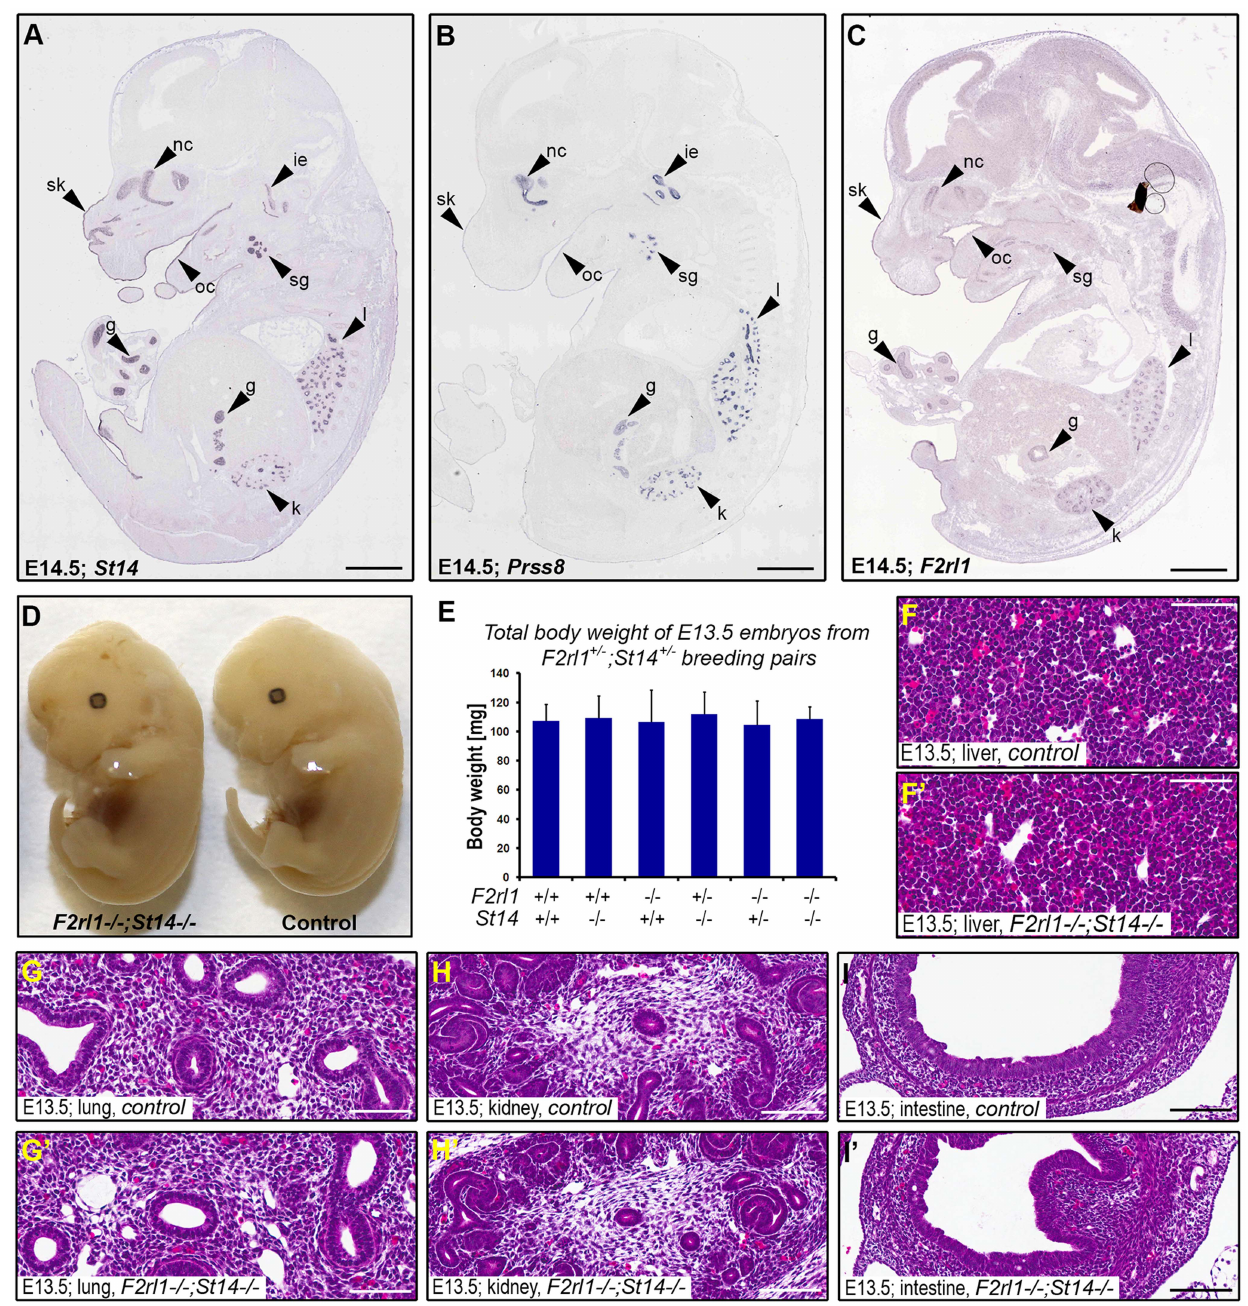
Figure 2. Loss of PAR-2 and matriptase does not affect development of the embryo proper. ( A–C ). Evaluation of the expression pattern of St14 ( A ), Prss8 ( B ), and F2rl1 ( C ) genes in E14.5 mouse embryo by in situ hybridization obtained from the Eurexpress digital transcriptome atlas. All three genes show highly overlapping pattern of expression in the epithelia of developing skin (sk), oral (oc) and nasal (nc) cavities, salivary gland (sg), lungs (l), kidney (k), and gut (g). Matriptase and prostasin, but not PAR-2, were also detected in the developing structures of the inner ear (ie). ( D ). Macroscopic appearance of F2rl1 2 / 2 ;St14 2 / 2 , and wild-type littermate control embryos at E13.5. No obvious developmental abnormality was observed in the PAR-2 and matriptase double-deficient animals. ( E ) Total body weight of E13.5 offspring from F2rl1 + / 2 ;St14 + / 2 breeding pairs. None of the embryos with a decreased combined gene dosage of F2rl1 and St14 genes showed any signs of growth retardation. ( G–I 9 ). H&E staining of embryonic tissues with the highest relative expression of PAR-2 and matriptase. A comparative histological analysis of liver ( F, F 9 ), lungs ( G, G 9 ), kidneys ( H, H 9 ), and intestines ( I, I 9 ) from the control ( F, G , H , and I ) and littermate F2rl1 2 / 2 ;St14 2 / 2 ( F 9 , G 9 , H 9 , and I 9 ) E13.5 embryos indicates normal development of embryonic tissues in the absence of PAR-2 and matriptase function. Scale bars: ( A–C ) 1 mm, ( F–I 9 ) 100 um.